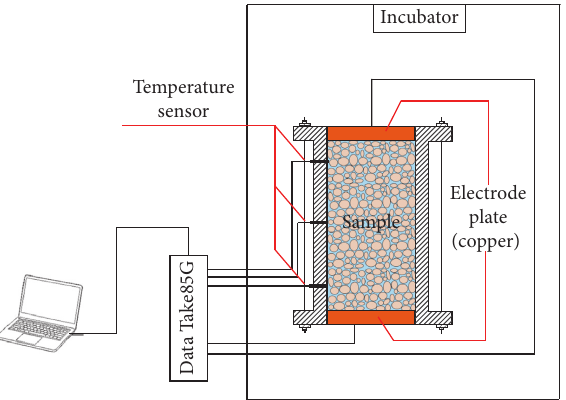
Figure 1: The electrical conductivity test